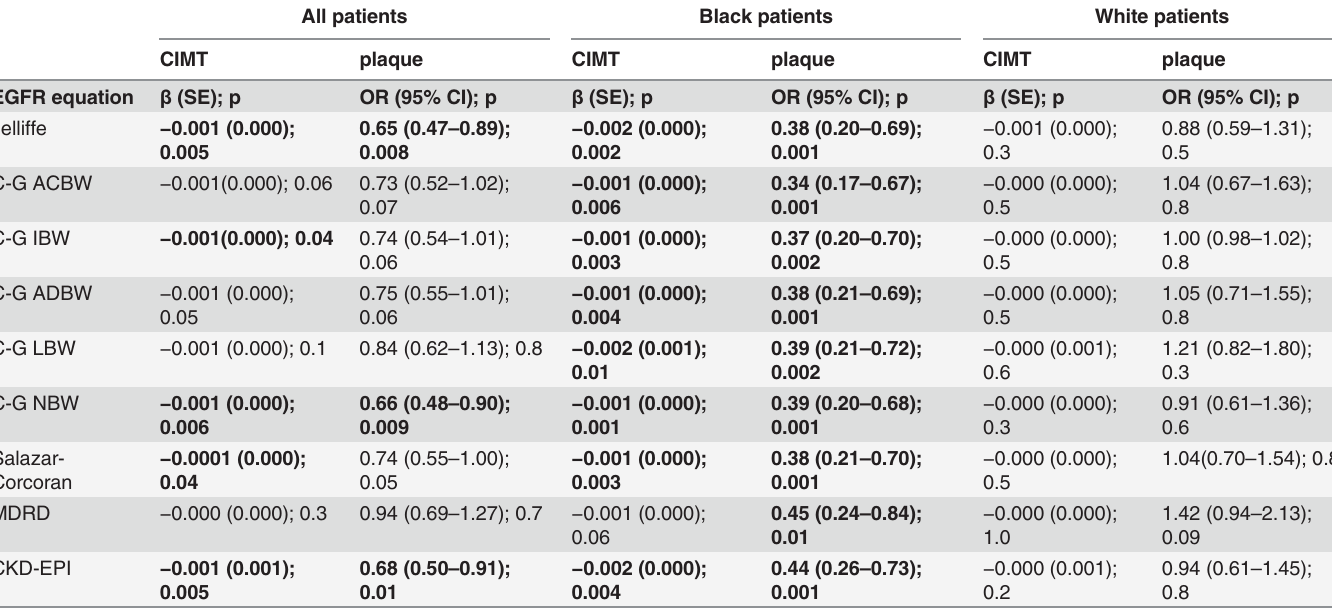
Table 4. Associations of EGFR with carotid intima-media thickness and plaque (per 1 SD increase in eGFR) in all, black and white patients with RA. All patients Black patients White